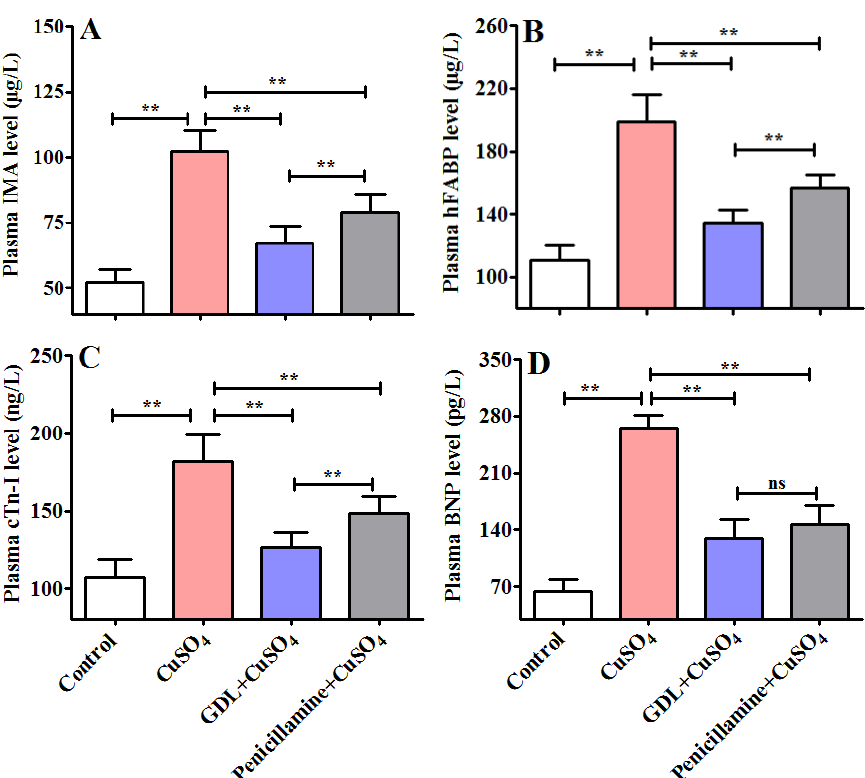
Figure 2. Effects of Gandouling (GDL) on copper sulfate (CuSO 4 ) -induced heart injury in rats. ( A ) Plasma ischemia-modified albumin (IMA). ( B ) Plasma heart-type fatty acid binding-protein (Hfabp). ( C ) Plasma cardiac troponin I (cTn-I). ( D ) Plasma Natriuretic peptide (BNP). ( A – D ) Data are presented as mean ± SD ( n = 10). ** p < 0.01. ns: no significance.